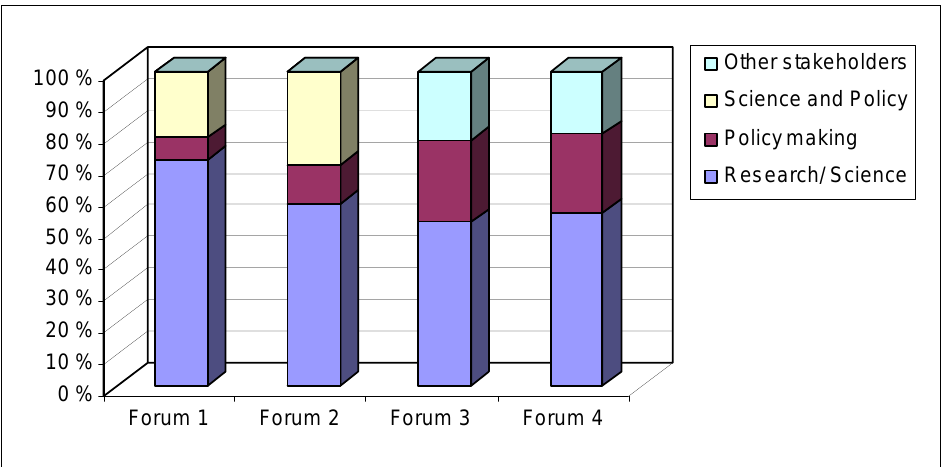
Figure 2. The backgrounds of Forum meeting participants